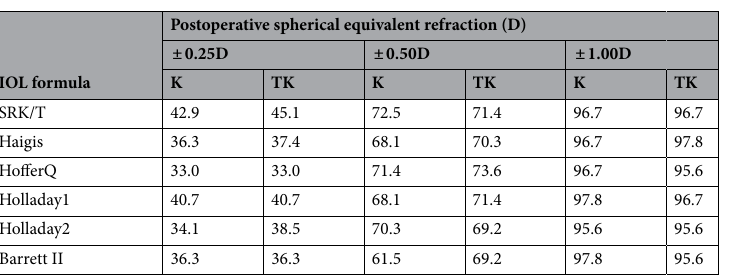
Table 3. Percentage of eyes within ± 0.25 D, ± 0.50 D, and ± 1.00 D of predicted postoperative spherical equivalent refraction (SE) between all formulas using K and TK. Paired McNemar’s chi-square test, all p values > 0.05 between the K and TK groups. K keratometry, TK total keratometry, IOL intraocular